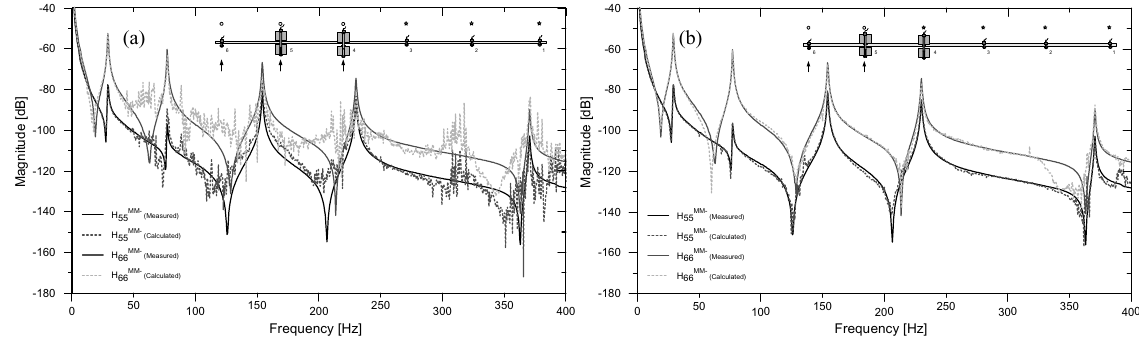
Fig. 16. Measured and estimated Receptances H (cid:2) 55 and H (cid:2) 66 for the MM- structure (a) Case III and (b) Case IV.